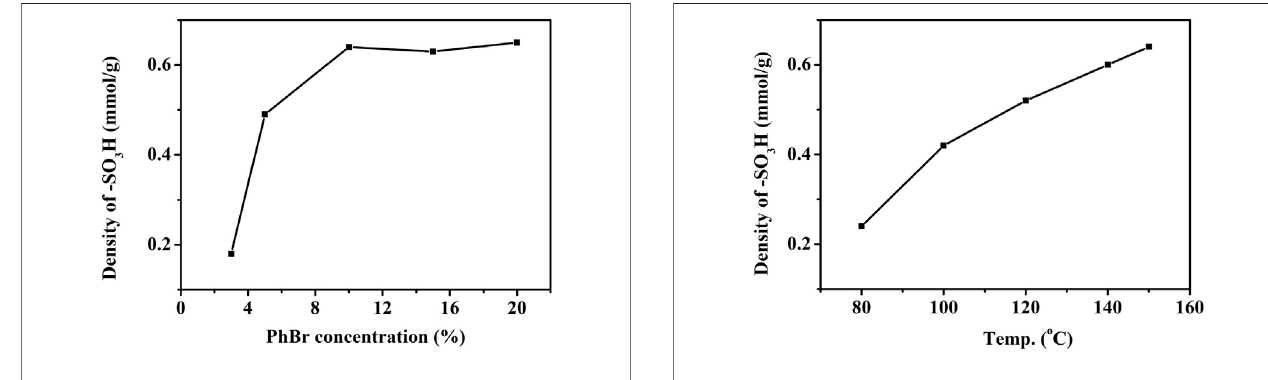
FIGURE3| Densityof-SO 3 HofAC-Ph-SO 3 Hunderdifferentsulfonation temperature.